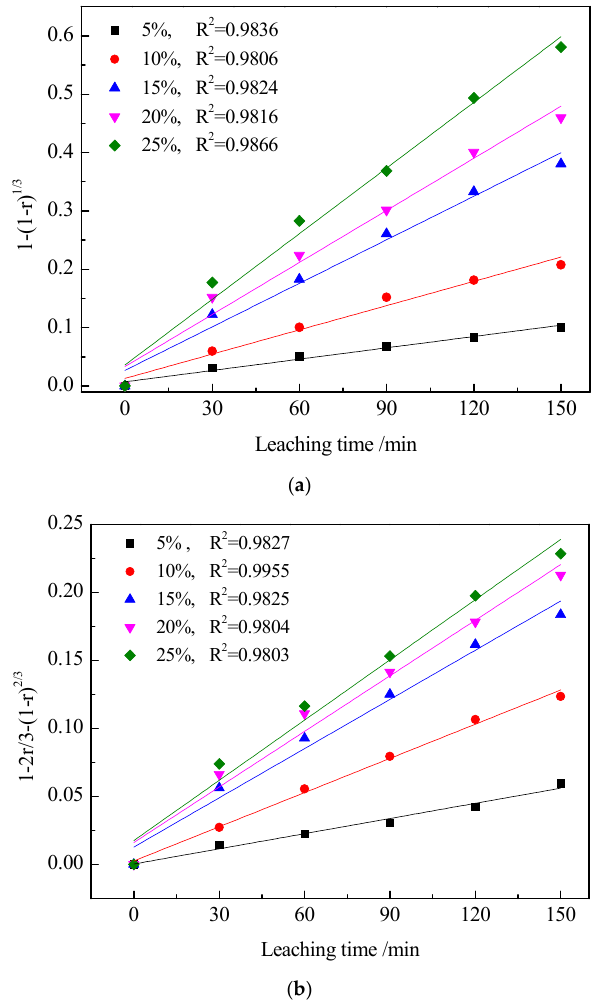
Figure 13. Plots of different sulfuric acid concentrations versus time. ( a ) Blank roasting clinker; ( b ) Calcified roasting clinker.